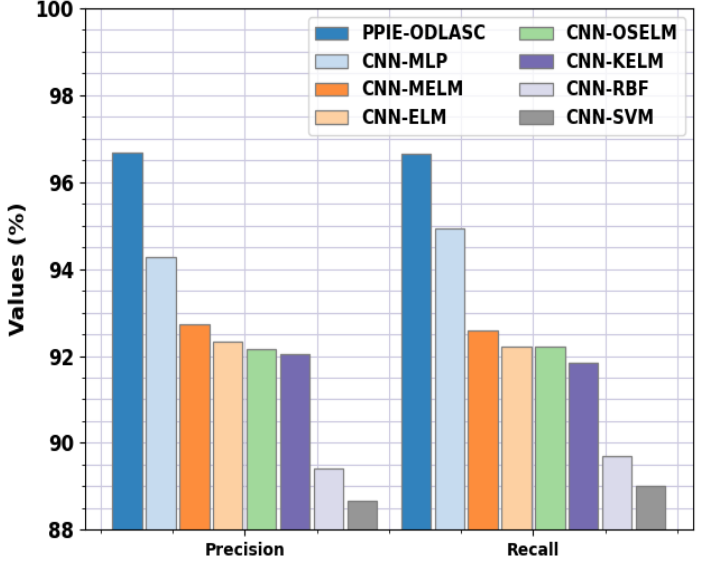
Figure 12. Prec n and Reca l analysis of the PPIE-ODLASC approach with other recent systems. and analysis of the PPIE-ODLASC approach with other recent systems. Figure 12. Figure 13 represents the comparative accident severity classification results of the PPIE- 𝑃𝑃𝑟𝑟𝑆𝑆𝑐𝑐 𝑛𝑛 𝑃𝑃𝑆𝑆𝑐𝑐𝐸𝐸 𝑙𝑙 ODLASC technique in terms of accu y and F score . The result shows that the PPIE-ODLASC technique has reached enhanced performance. Based on accu y , the PPIE-ODLASC technique has acquired increased accu y values of 98.32%, while the CNN-MLP, CNN-MELM, CNN-ELM, CNN-OSELM, CNN-KELM, CNN-RBF, and CNN-SVM methods have reported reduced accu y values of 94.80%, 92.66%, 92.03%, 91.28%, 92.29%, 89.30%, and 86.83%, respectively.